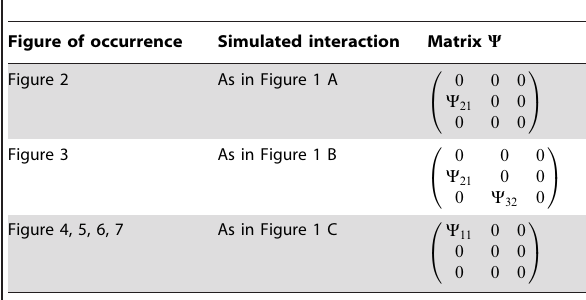
Figure of occurrence Simulated interaction Matrix Y Figure 2 As in Figure 1 A